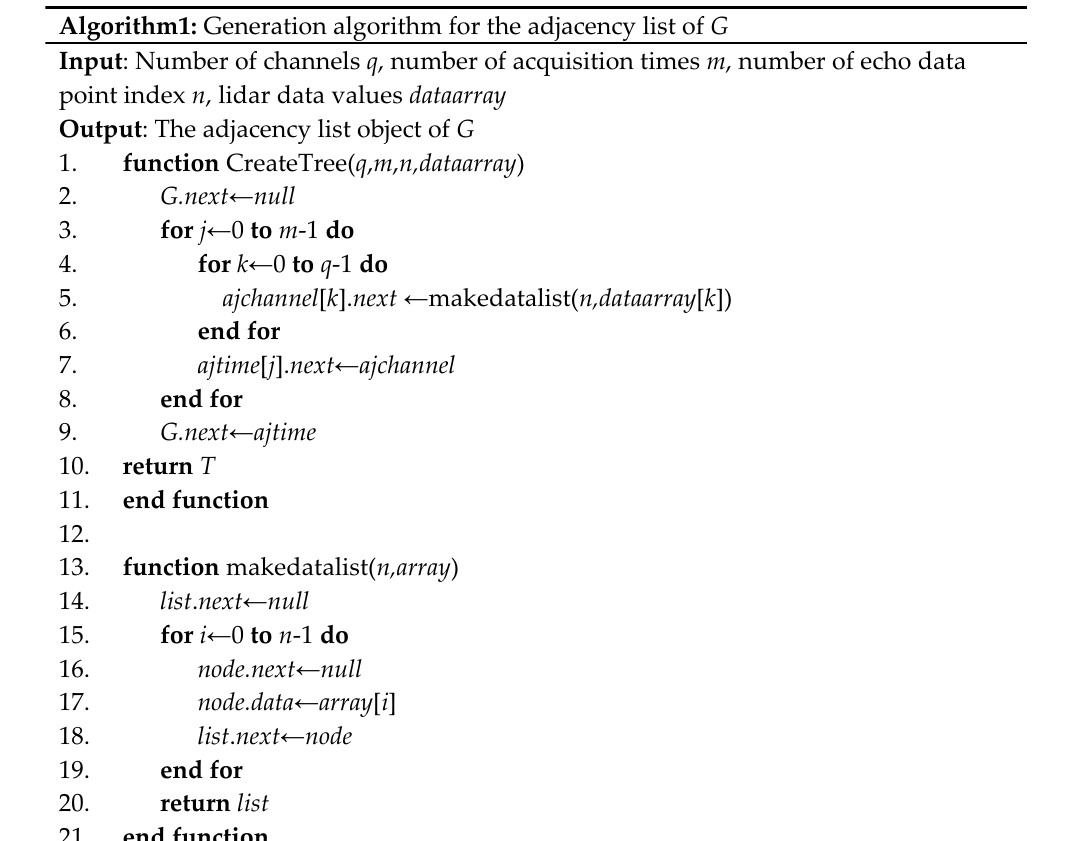
Table 1. The generation algorithm for the adjacency list of G.